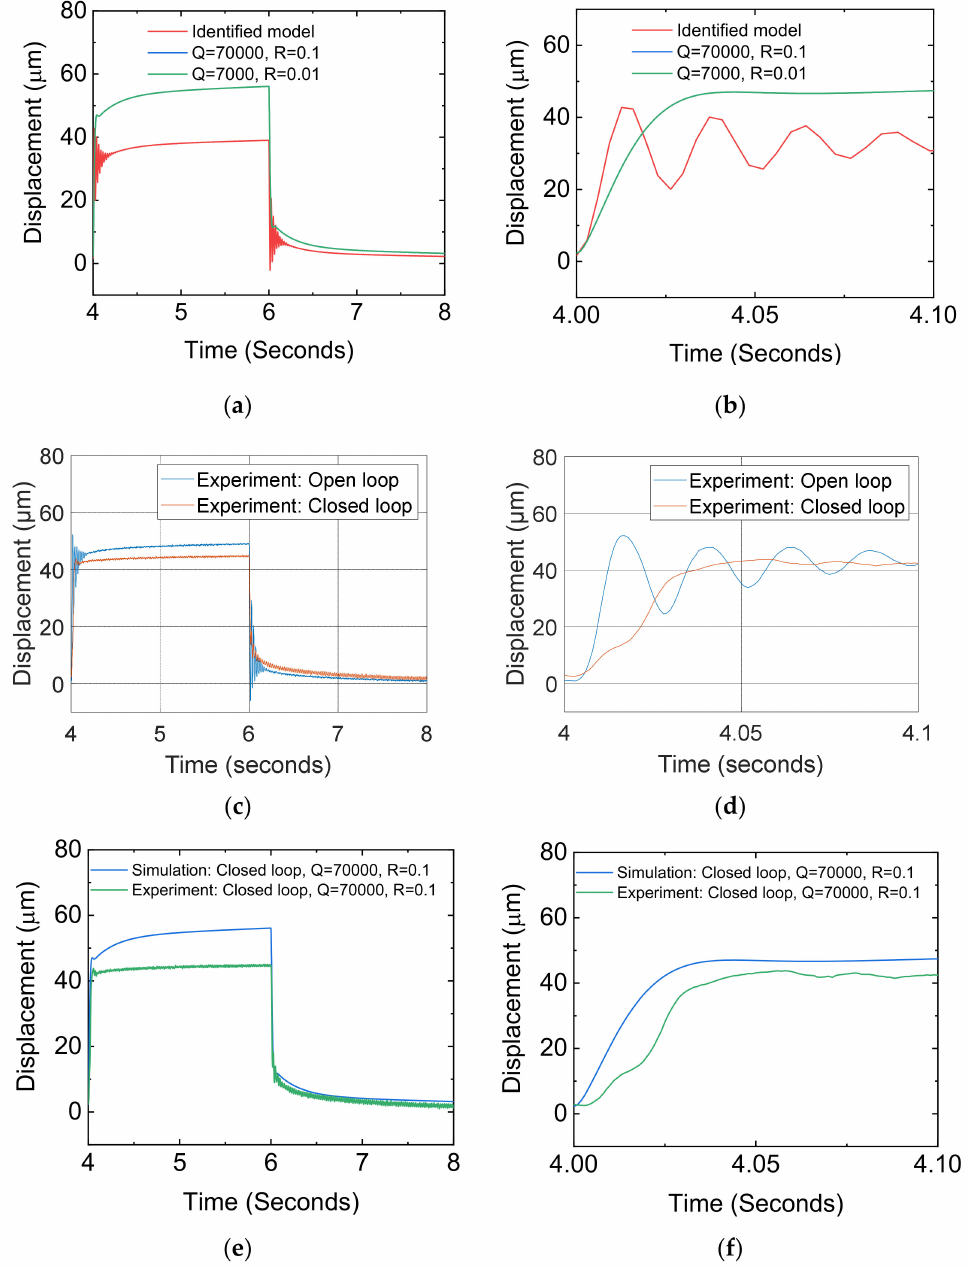
Figure 8. ( a ) Comparison of the identified DEA model and the closed-loop simulation for one voltage cycle; ( b ) A close-up of (a) For comparison of the identified DEA model and the closed-loop simulation for 100 ms duration; ( c ) Open-loop vs closed-loop experiment for one voltage cycle; ( d ) A close-up of ( c ) for 100 ms duration; ( e ) Comparison of closed-loop experiment and closed-loop simulation for one voltage cycle; and, ( f ) A close-up of ( e ) for 100 ms